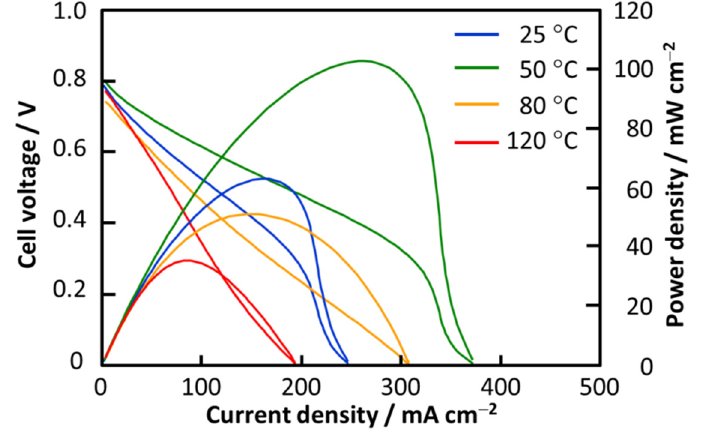
Figure 6. i – V and i – P characteristic curves of a single cell using EMPyr(FH) 1.7 F/PVdF-HFP (7:3) composite membrane at 25  120  C under nonhumidified conditions. Anode and cathode catalyst: 1.0 mg Pt·cm − 2